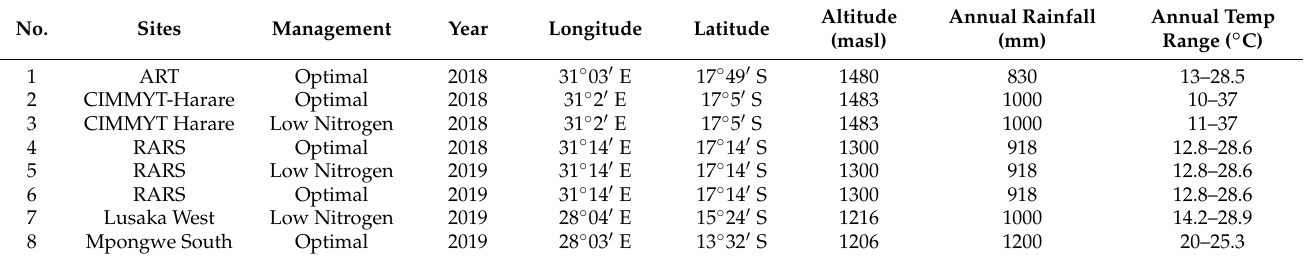
Table 2. Characteristics of the testing sites used to evaluate single-cross hybrids in Zimbabwe and Zambia in 2018 and